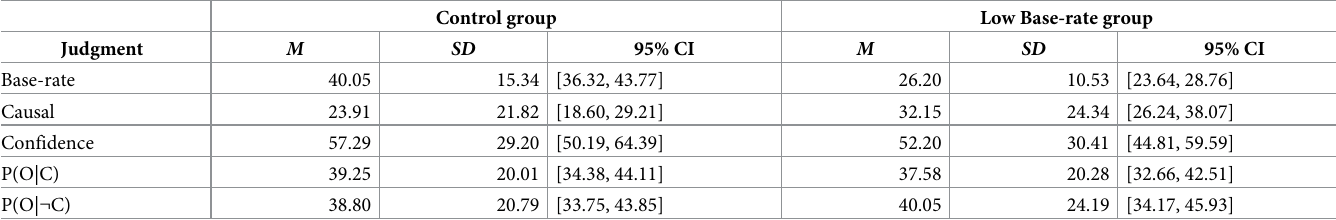
Table 4. Descriptive statistics of the five judgments collected in Experiment